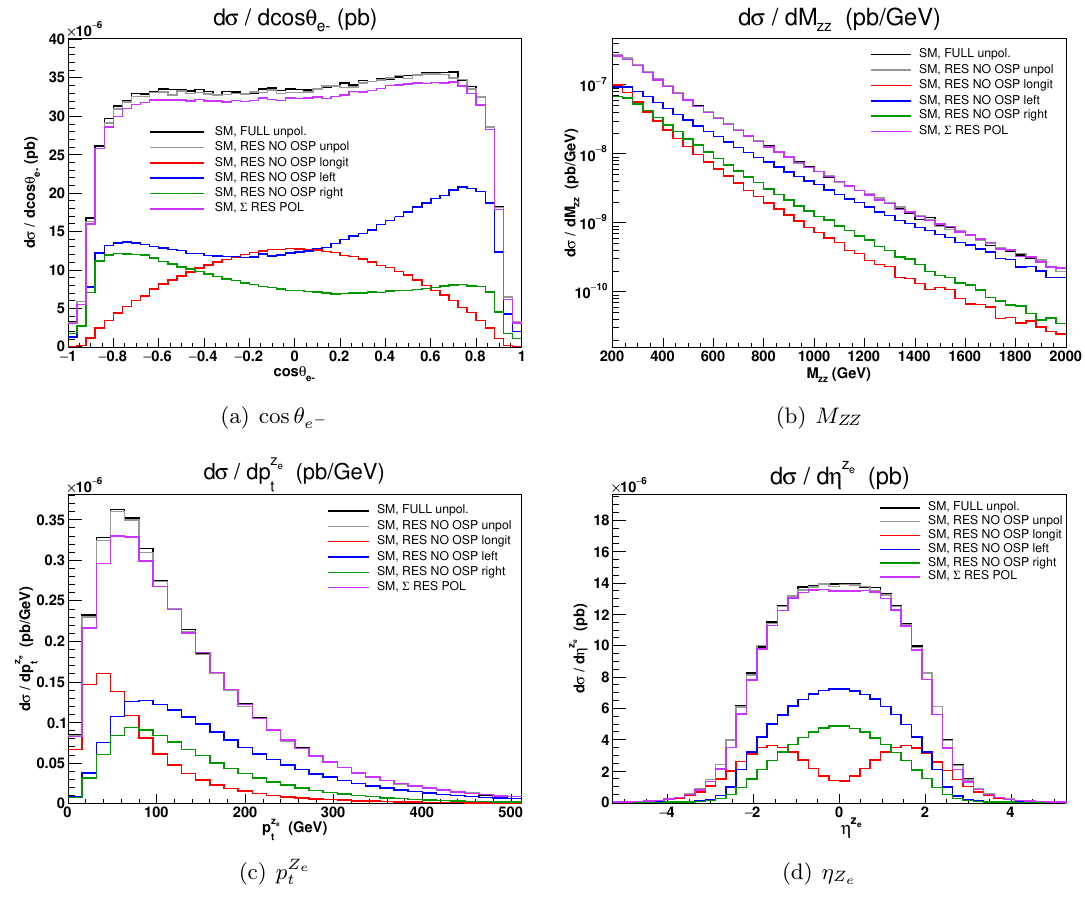
Figure 4 . ZZ scattering: polarized distributions in the presence of lepton cuts, obtained integrating the polarized amplitudes squared. The Z decaying to e + e (cid:0) is polarized, the one decaying to (cid:22) + (cid:22) (cid:0) is unpolarized. The sum of polarized components (violet curve) is compared against the full unpolarized distribution (black